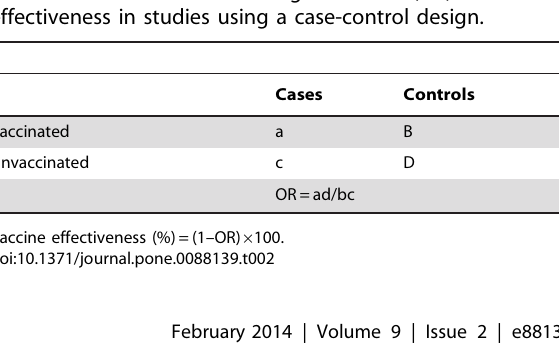
Table 2. Formula for calculating odds ratio (OR) and vaccine effectiveness in studies using a case-control design.